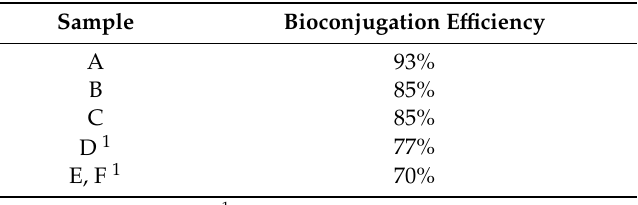
Table 5. Description of the samples submitted to cell uptake analyses.